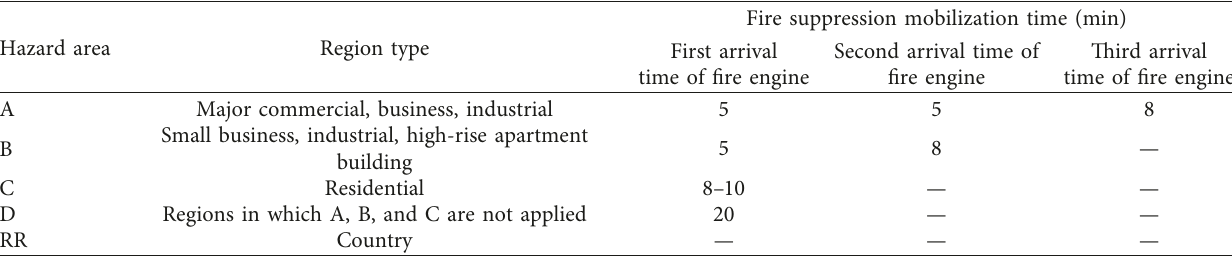
Table 5: Mobilization time criteria for fire suppression in the UK [25, 26].